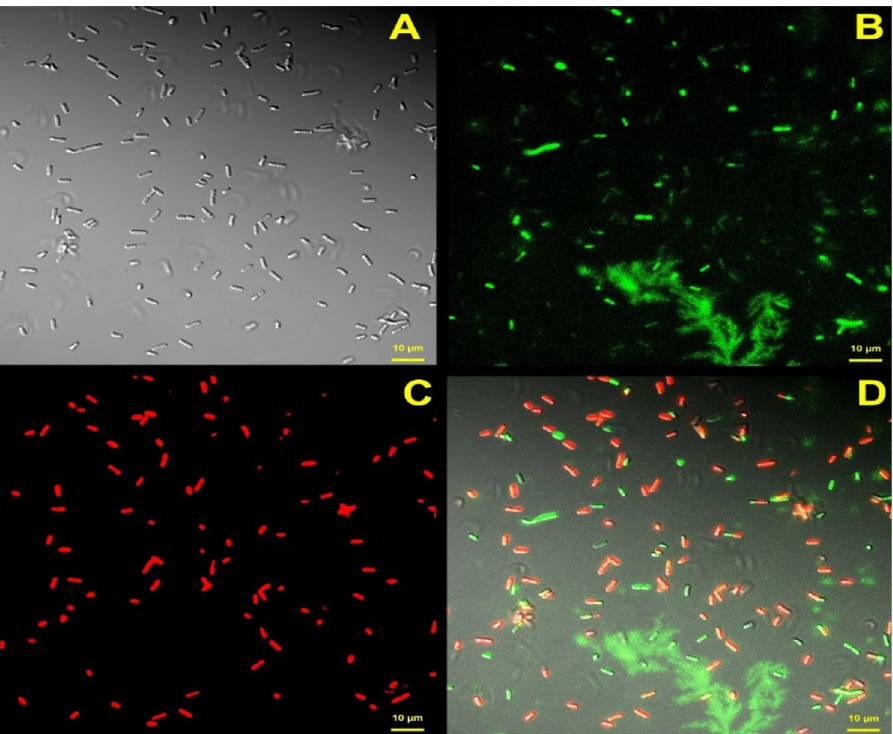
Figure 3. Laser Scanning Confocal microscopy imaging of High-level inoculated B. cereus cells in the liquid- type cosmetic aged for 14 days and then stained with Live/Dead dye. Live cells are green and dead/injured cells